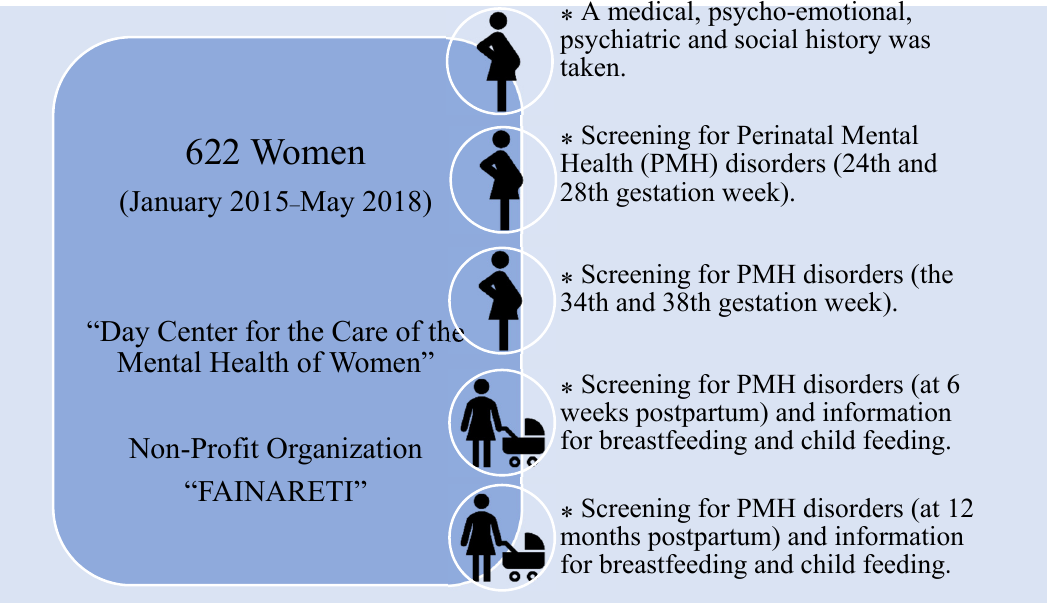
Figure 1. Flowchart regarding the data collection.